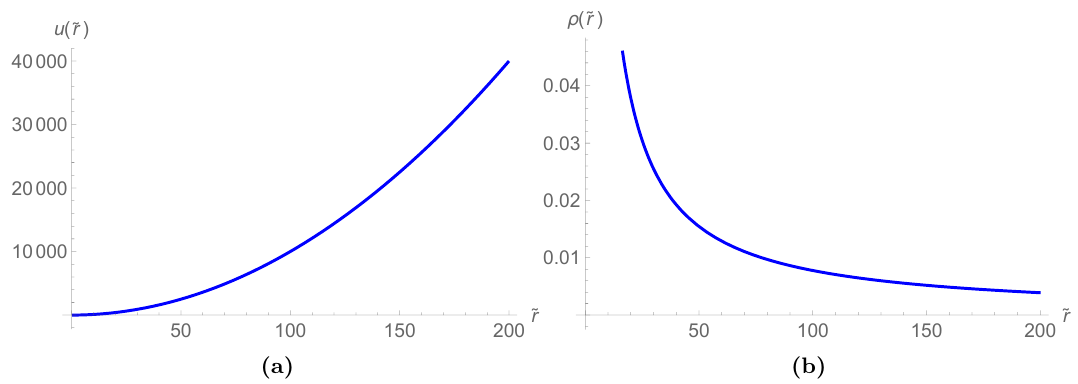
Figure 1. Numetrical solutions for a Q-lattice Black brane and a AdS Q-soliton with ~ k = 0 : 6336, (cid:26) (1) = 0 : 4000 and w 0 (1) = w 1 (1) = 10 (cid:0) 4